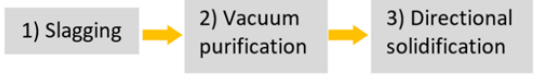
Figure 7. Descriptive sketch of the purification process at FerroSolar.